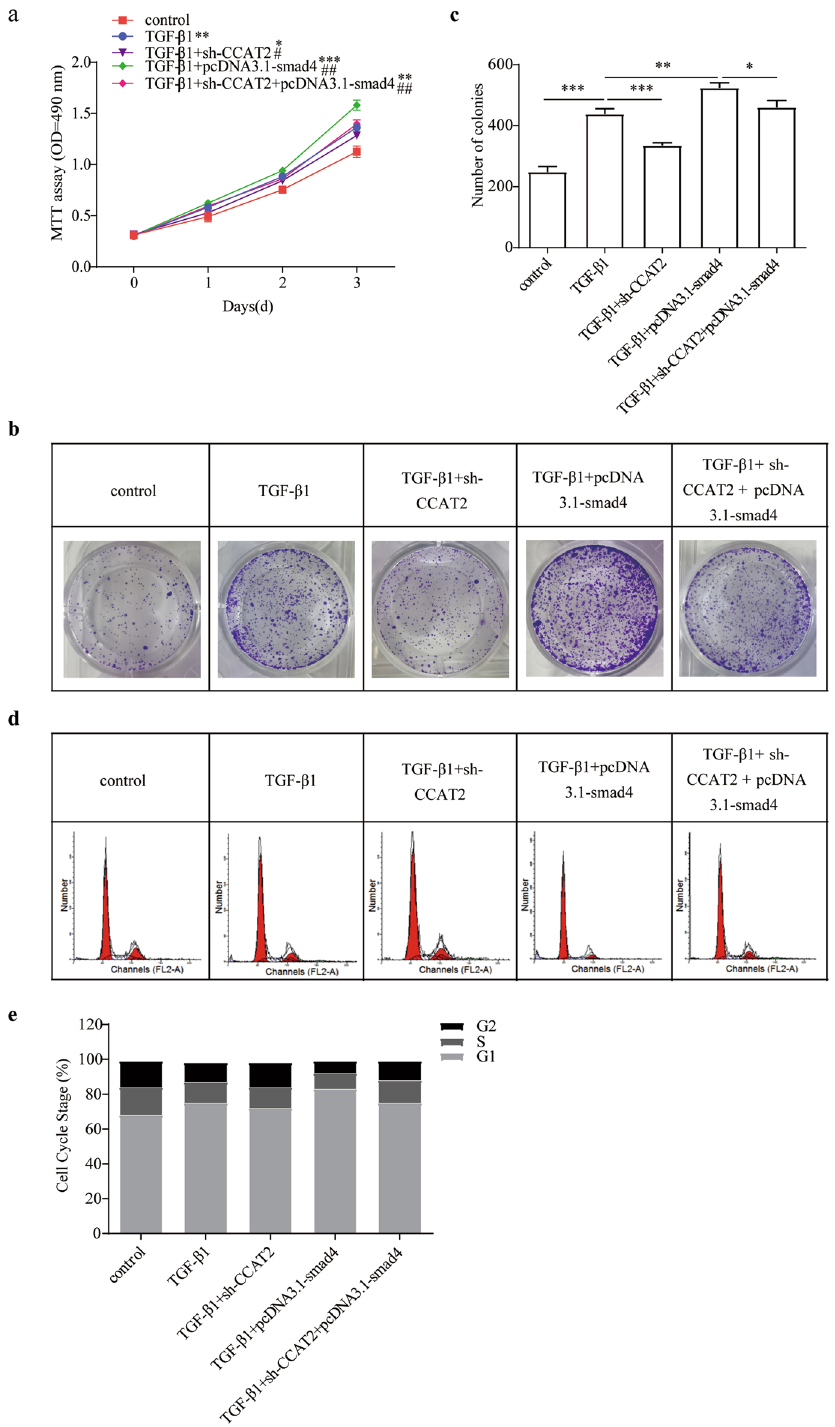
Figure 8. TGF-β1 and Smad4 are downstream signaling of CCAT2 in HSCs. ( a ) Comparison of cell proliferation of HSCs co-transfected with TGF-β1 and sh-CCAT2, pcDNA3.1-Smad4 was determined by MTT assay. ( b ) Colony formation assay and ( c ) the quantification. ( d ) Cell-cycle distribution by flow cytometry, and statistical analysis of distribution of HSCs cell cycle stages ( e